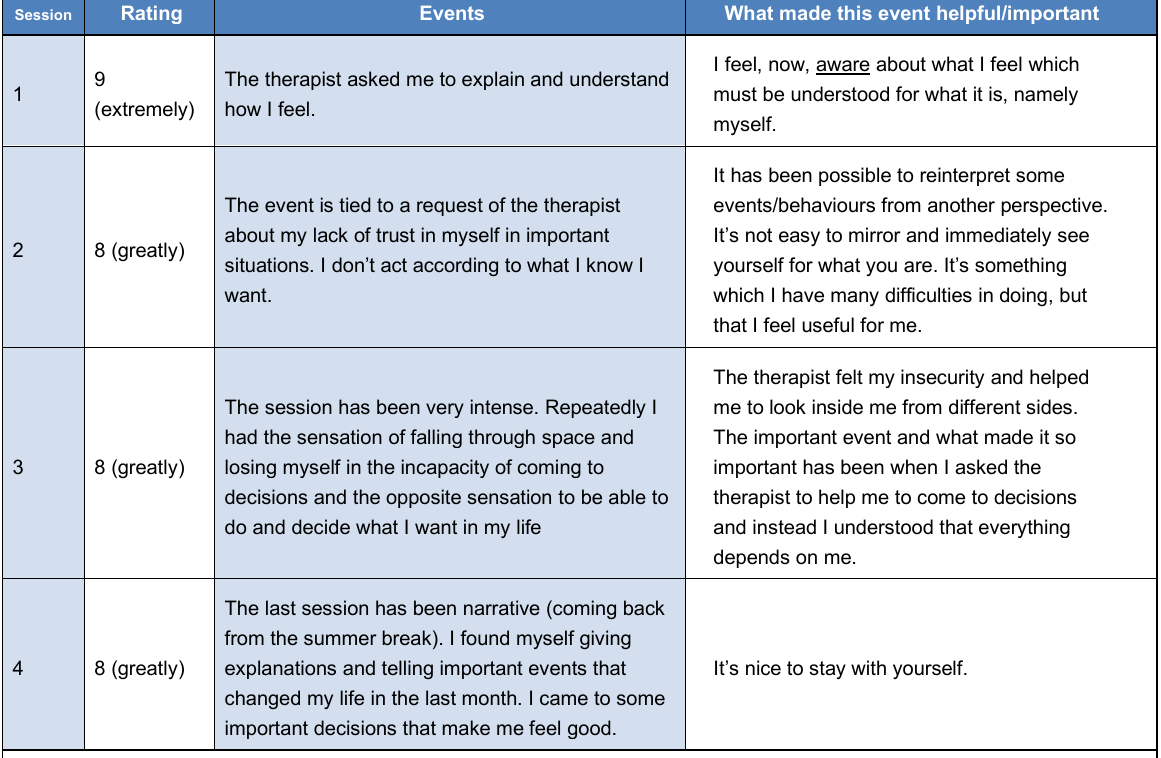
Table 2: Beatrice’s personal problems (PQ), duration and scores